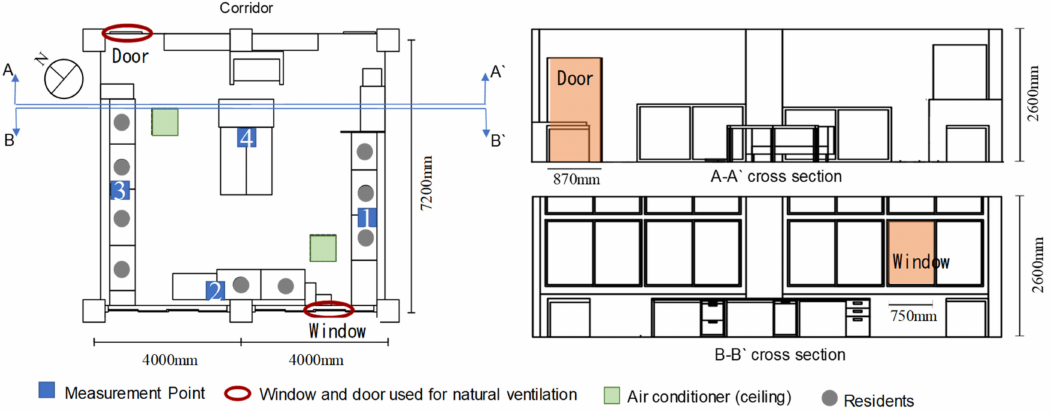
Figure 2. Measurement position and cross section.